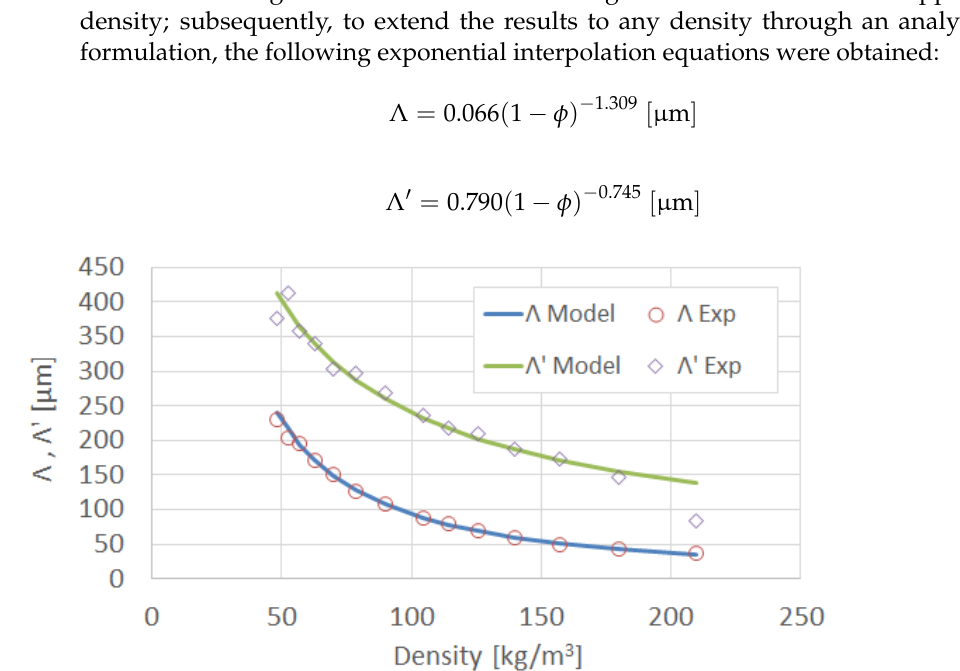
Figure 8. Comparison between the values of Λ and Λ ’ obtained by inversion from the experimental measurements and interpolation curves (12) and (13).